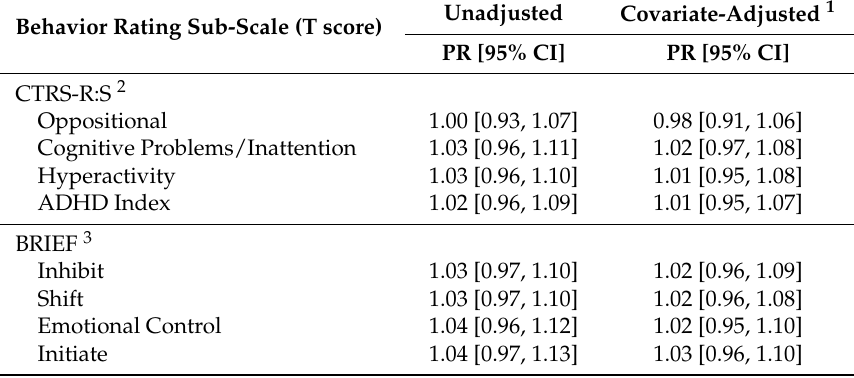
Table 3. Association (prevalence ratio) between blood lead concentrations and behavior ratings by teachers, comparing children with BLL ≥ 5 to those with <5 µ g/dL ( n =